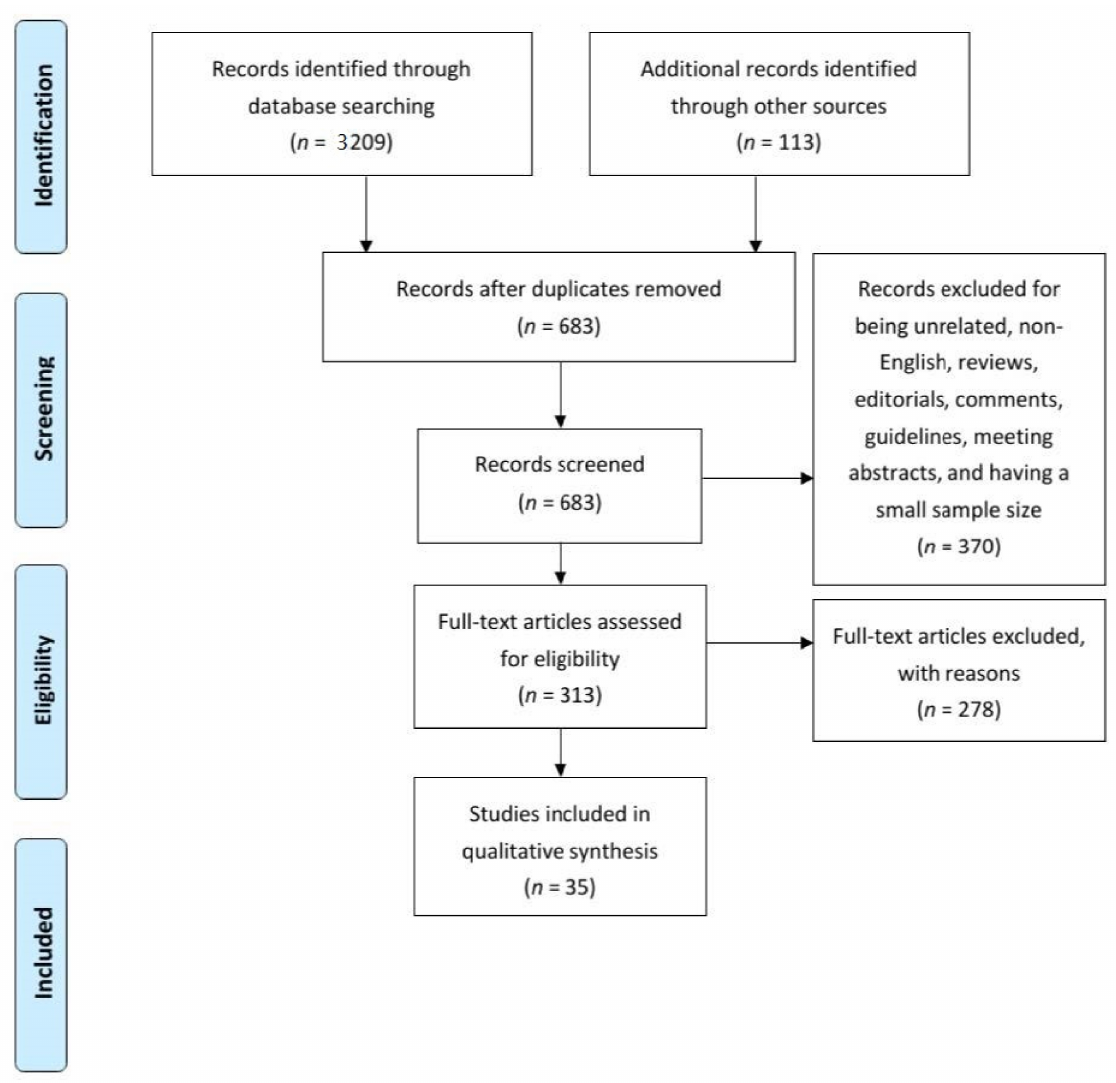
Figure 1. The Preferred Reporting in Systematic Reviews and meta-Analyses flowchart for article